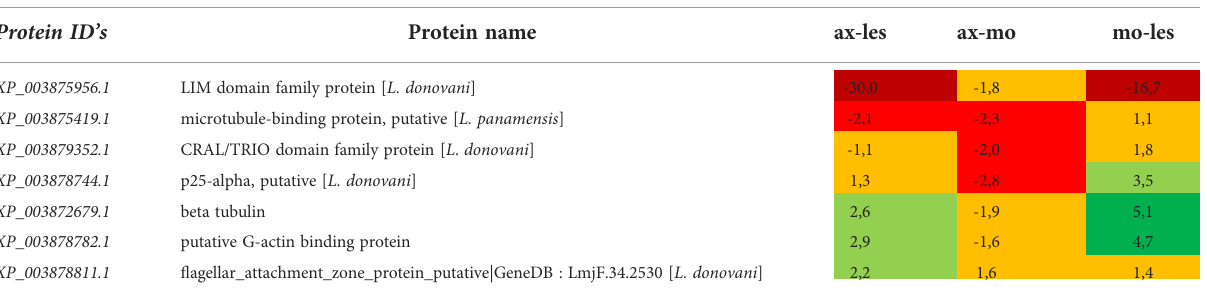
TABLE 9 Cytoskeleton proteins identi fi ed in all 3 comparisons that differ by at least 2-fold (T-test signi fi cant) between individual amastigote types.